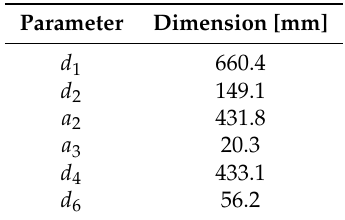
Table 2. Parameter dimensions of PUMA